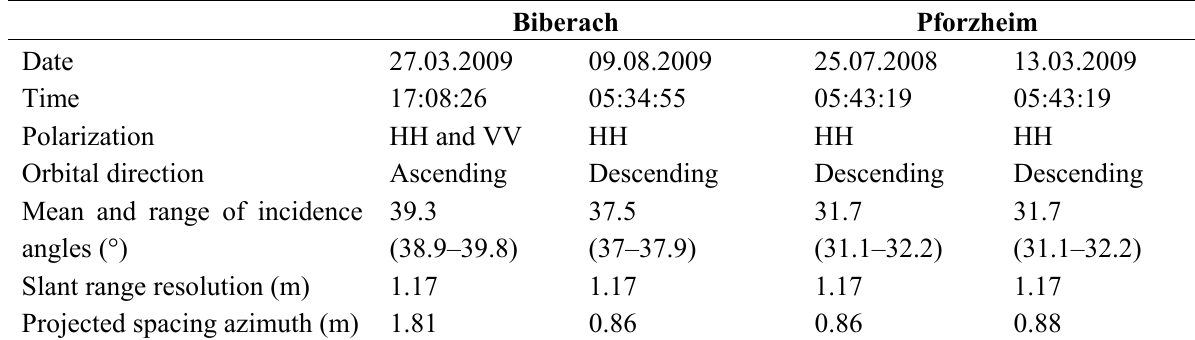
Table 1. Properties of High Resolution SpotLight (HS) TerraSAR-X datasets. Biberach